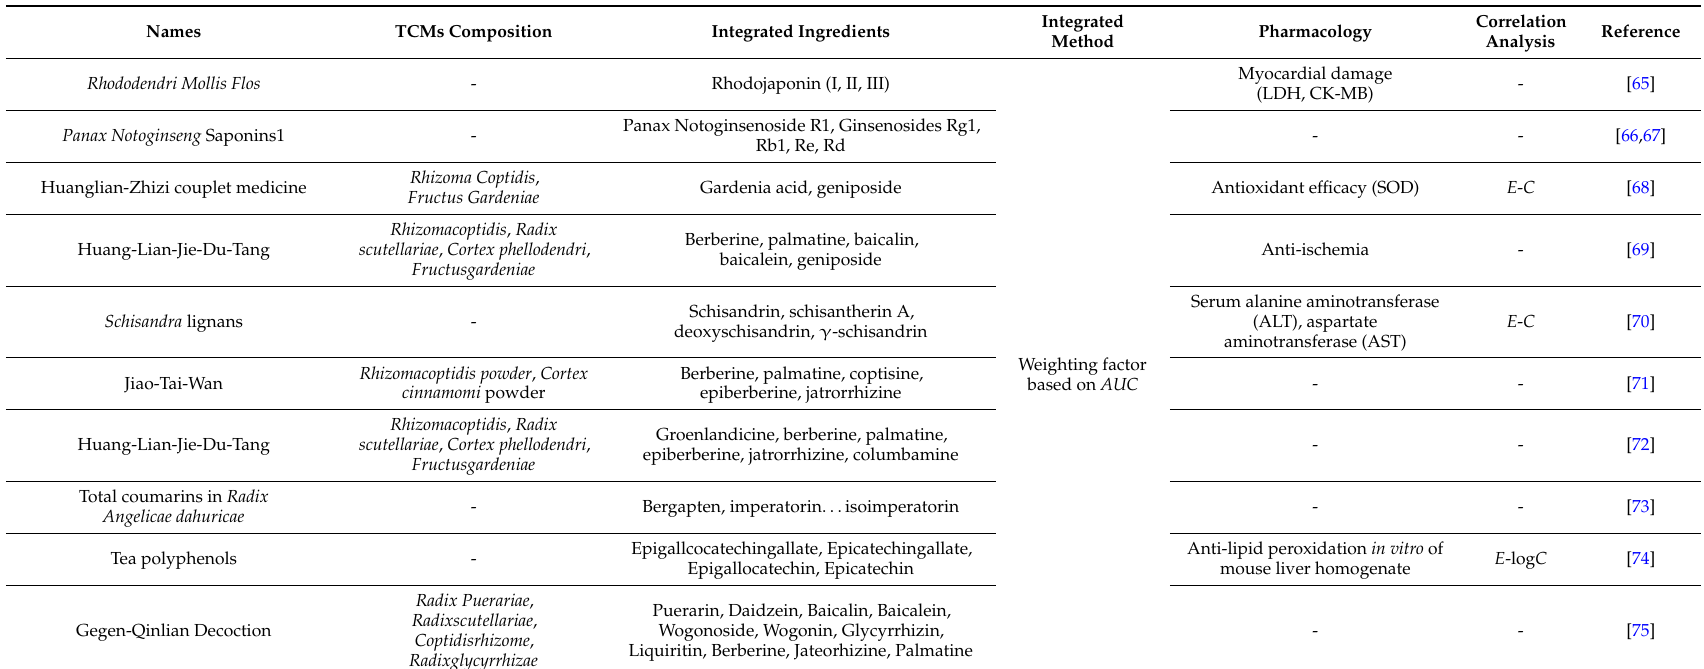
Table 4. Study on the integrated pharmacokinetics in